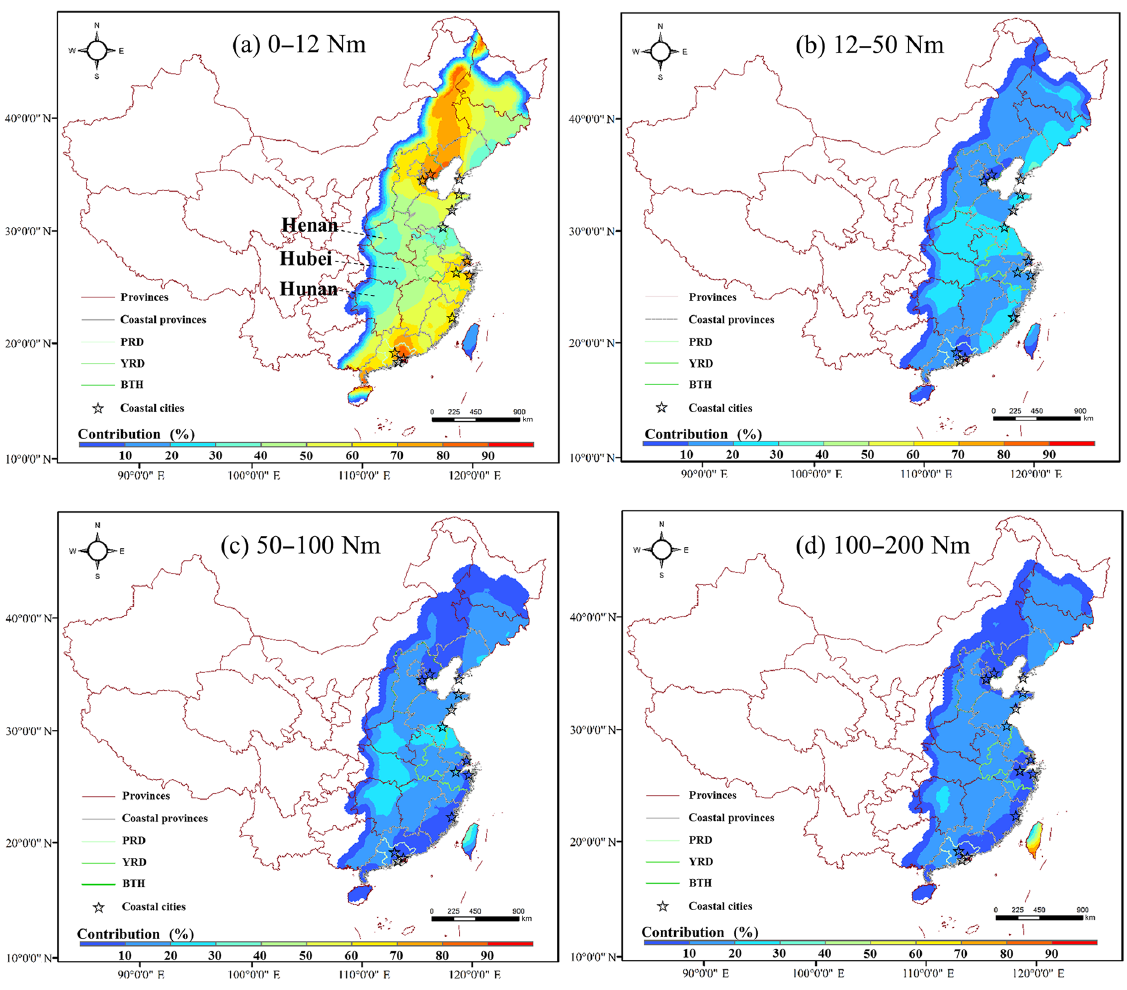
Figure 8. Contributions of shipping emissions in different maritime areas to the total ship-induced PM 2 . 5 concentration: (a) within 0–12Nm, (b) within 12–50Nm, (c) within 50–100Nm and (d) within